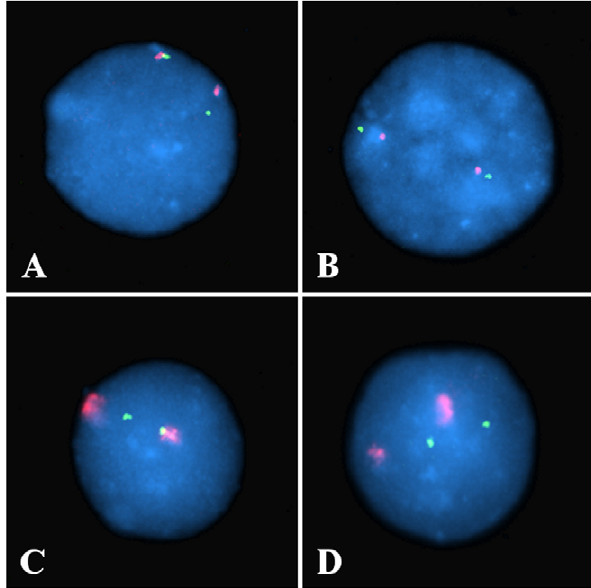
Figure 11. Gene-heterochromatin co-localization assessment. Co-localisation was assessed by identifying gene signals (green) showing any degree of overlap with the classical satellite DNA signal (red). The co-localisation assessment was carried out independently from the heterochromatin spatial configuration (‘‘conventional’’ in A and B, and ‘‘compact’’ in C and D) and the intra-nuclear positioning of both gene and heterochromatic signals.